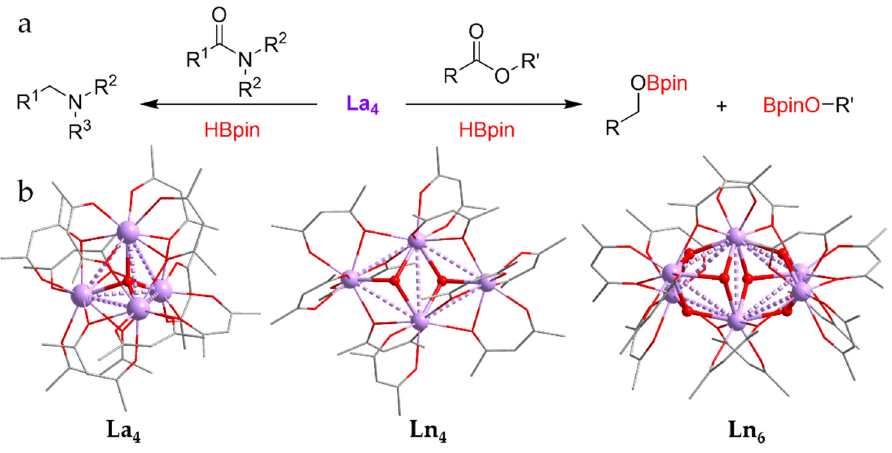
Figure 8. ( a ) The reduction of esters and carboxamides (1°, 2° and 3°) with catalyst of La 4 . ( b ) The structures of La 4 , Ln 4 , and Ln 6 , respectively. Color legends: Ln, lavender; O, red; C, gray [56].